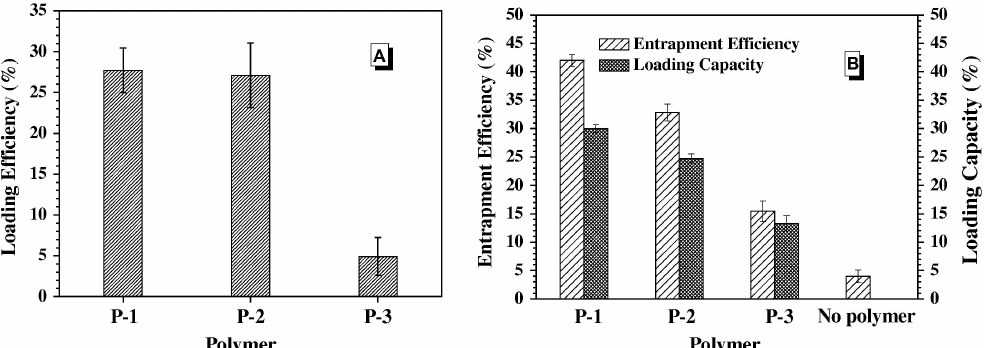
Figure 13. ( A ) Loading efficiency of Nile red. ( B ) Entrapment efficiency and loading efficiency of ibuprofen poly(lactide-co-glycolide)-cholesterol nanoparticles have also been tested for tumor- targeted delivery of curcumin through intravenous routes, which resulted in low cytotoxicity and high serum stability. P-1, P-2 and P-3 are polymers with gradually decreasing ratios of cholesterol content. Reprinted with permission from Liu et al., Journal of Colloid and Interface Science , 2012 , 377 , 197–206